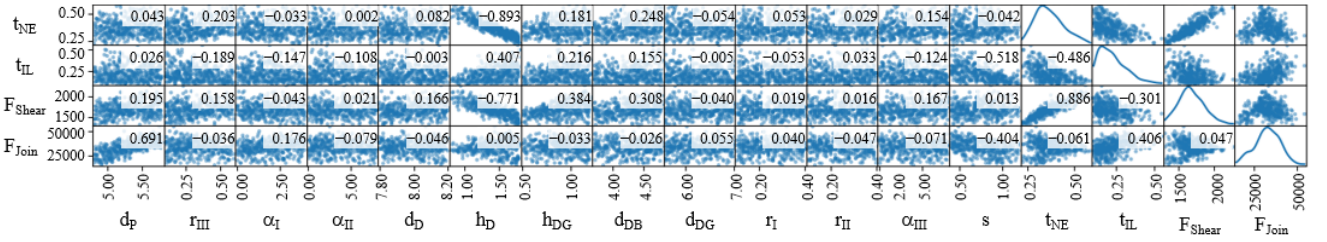
Figure 6. Illustration of the calculated Pearson’s correlation